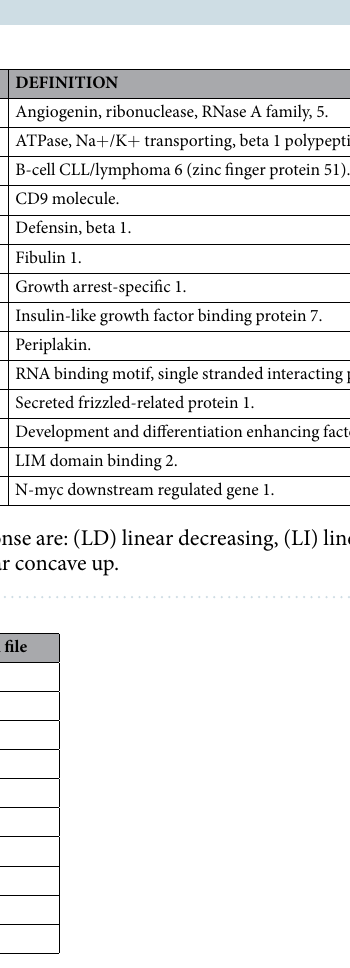
Table 3. ENCODE RNAseq experiments used for basic expression comparison. ( * ) Primary cell.